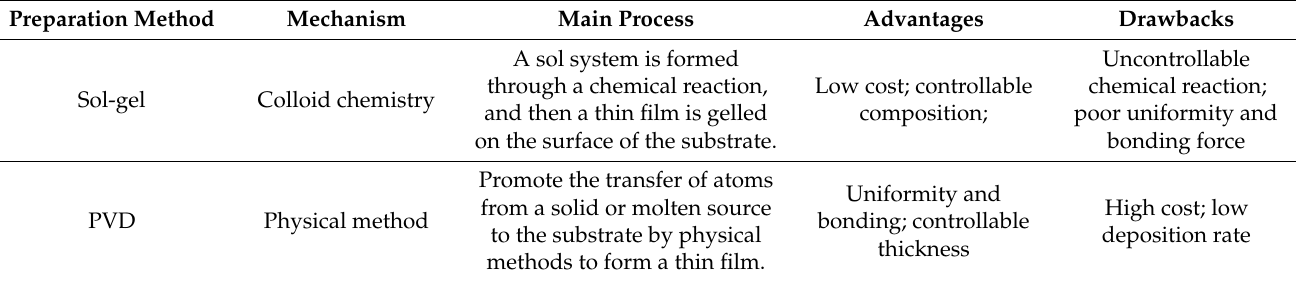
Table 1. Comparison of sol-gel method and PVD method.